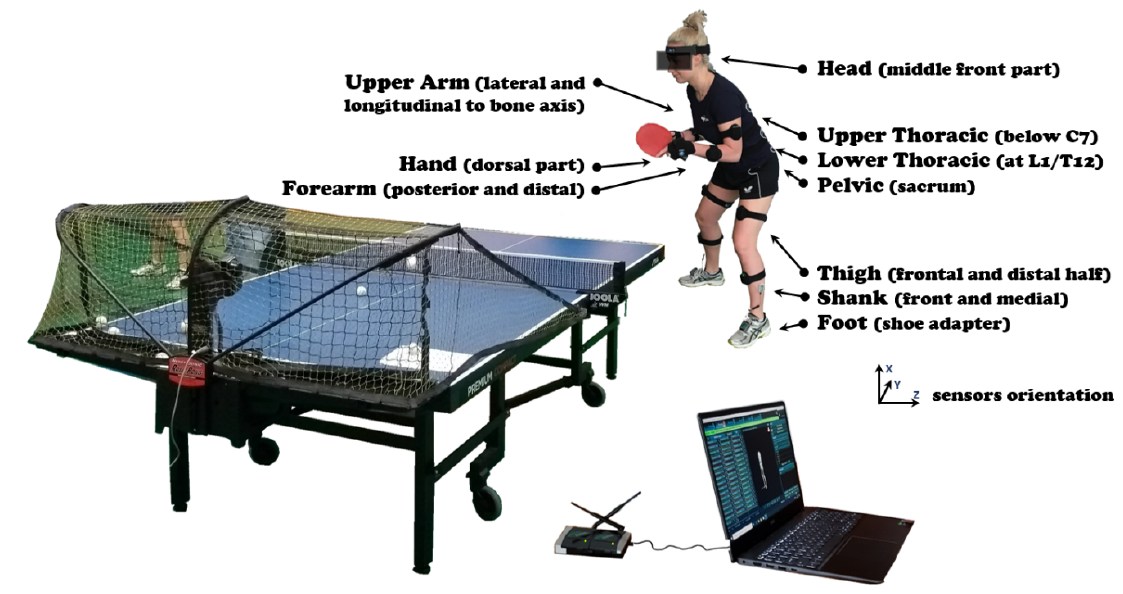
Figure 1. The measurement setup with the computer workstation, locations of the sensors on the player’s body.